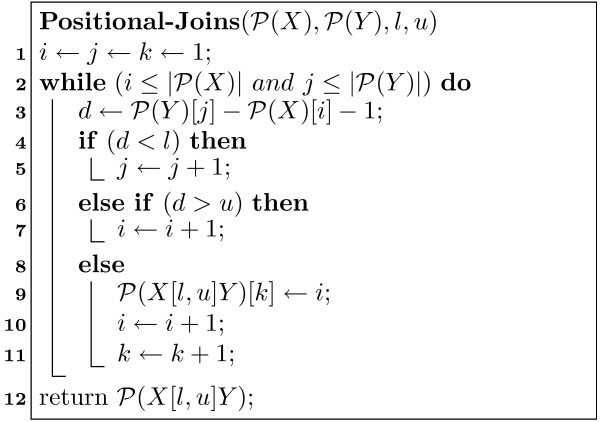
Positional Joins Algorithm.